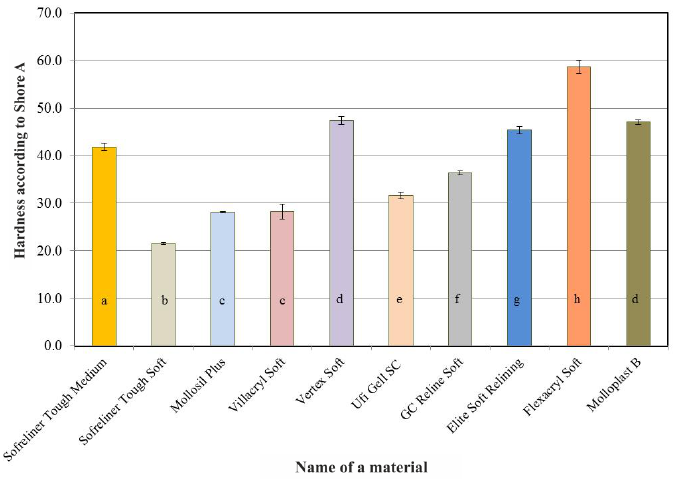
Figure 3. Average Shore A hardness values of the tested relining materials after 28 days of condi- tioning the samples in distilled water. The same letters denote mean values which do not differ statistically significantly.